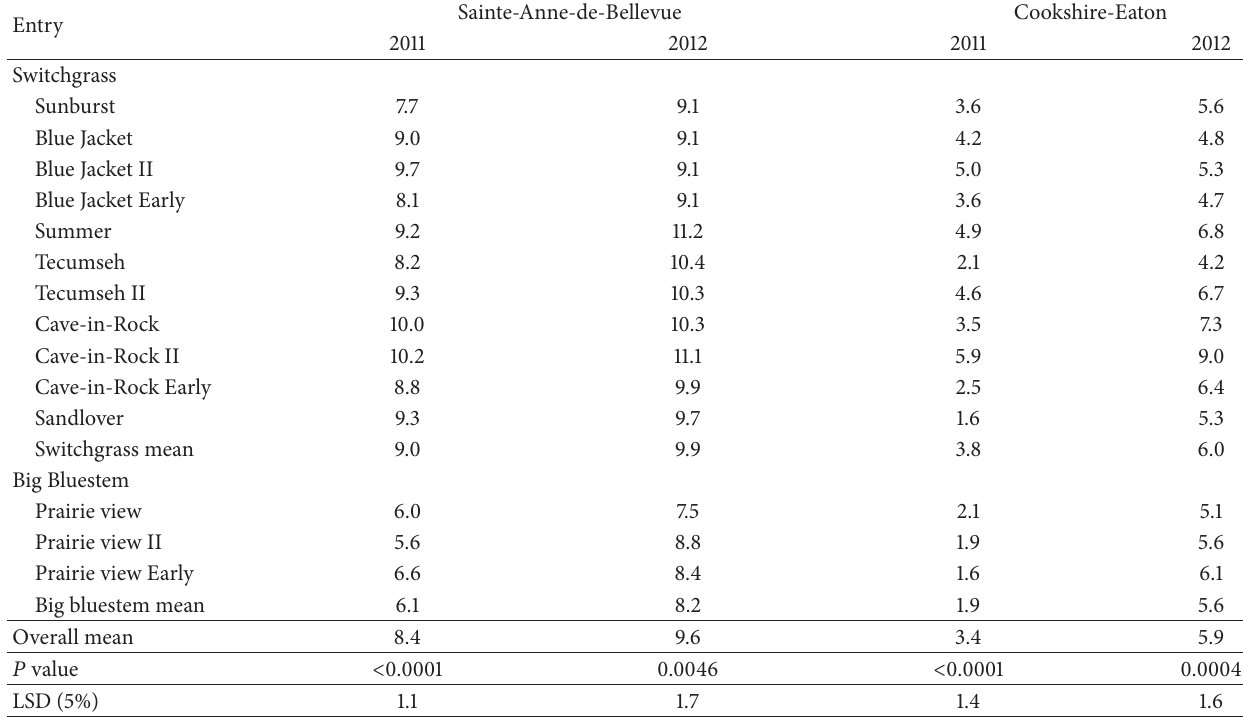
Table 2: Yield on dry matter basis of 11 selections of switchgrass and 3 selections of big bluestem seeded in 2010 and harvested in fall of 2011 and 2012 at two sites in Southern Quebec (in Mgha −1